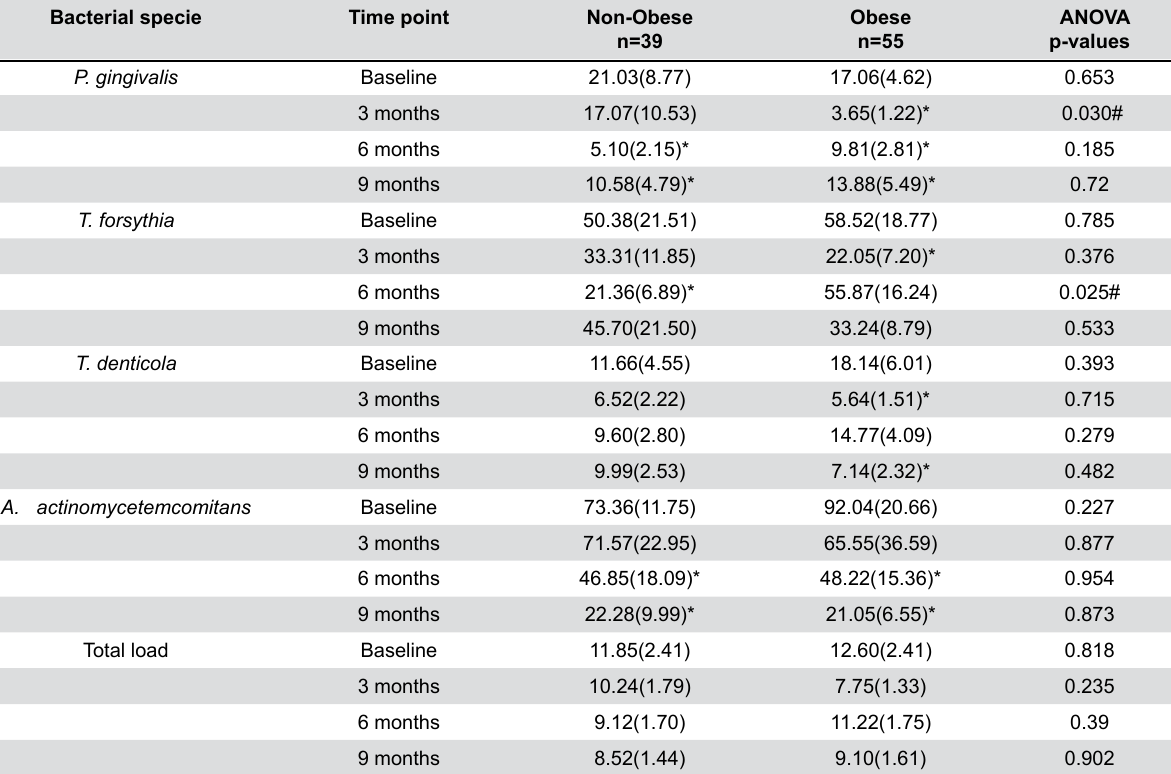
Table 3- Mean number of periodontal pathogens (SE) for both groups at baseline and at follow-up Bacterial specie